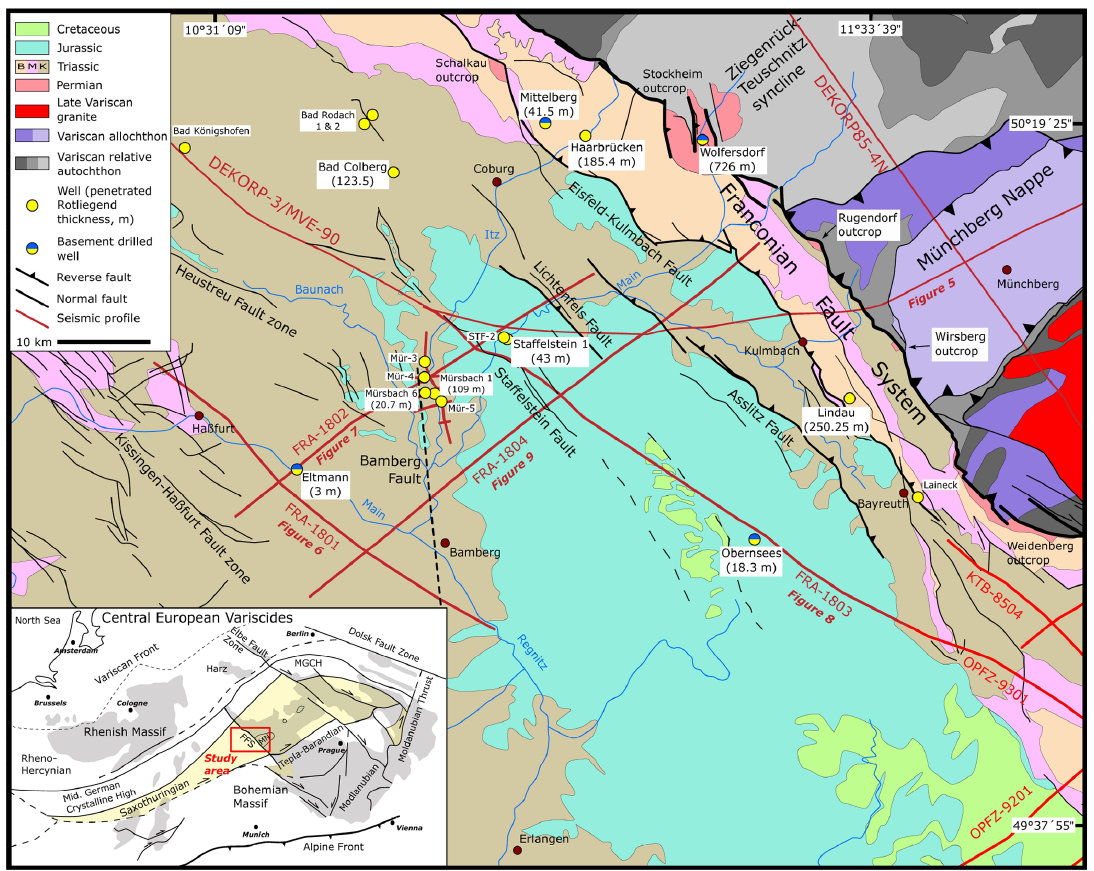
Figure 1. Location of the study area in the Saxothuringian Zone of the Variscan Orogen. The FRANKEN seismic survey is projected on geological map of the study area in dark red, creating a grid of 2D seismic profiles with existing DEKORP profiles. The main faults are shown as dark lines. The inset map shows exposed Variscan terranes in central Europe. Yellow circles show deep wells in the study area. FRA stands for FRANKEN, MGCH stands for Mid-German Crystalline High, FFS stands for Franconian Fault System, MN stands for Münchberg Nappe, Mür stands for Mürsbach, and STF stands for